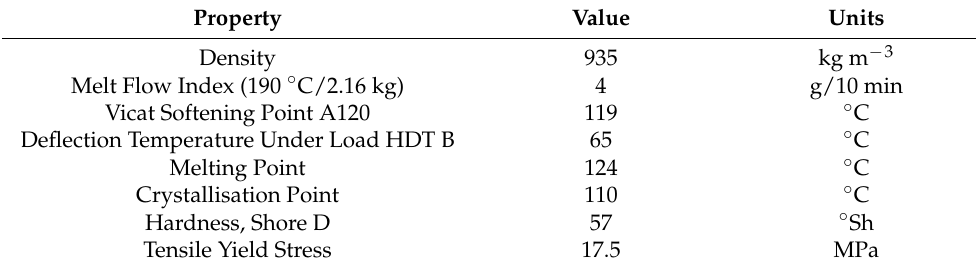
Table 1. Basic properties of the polymer used in the tests.